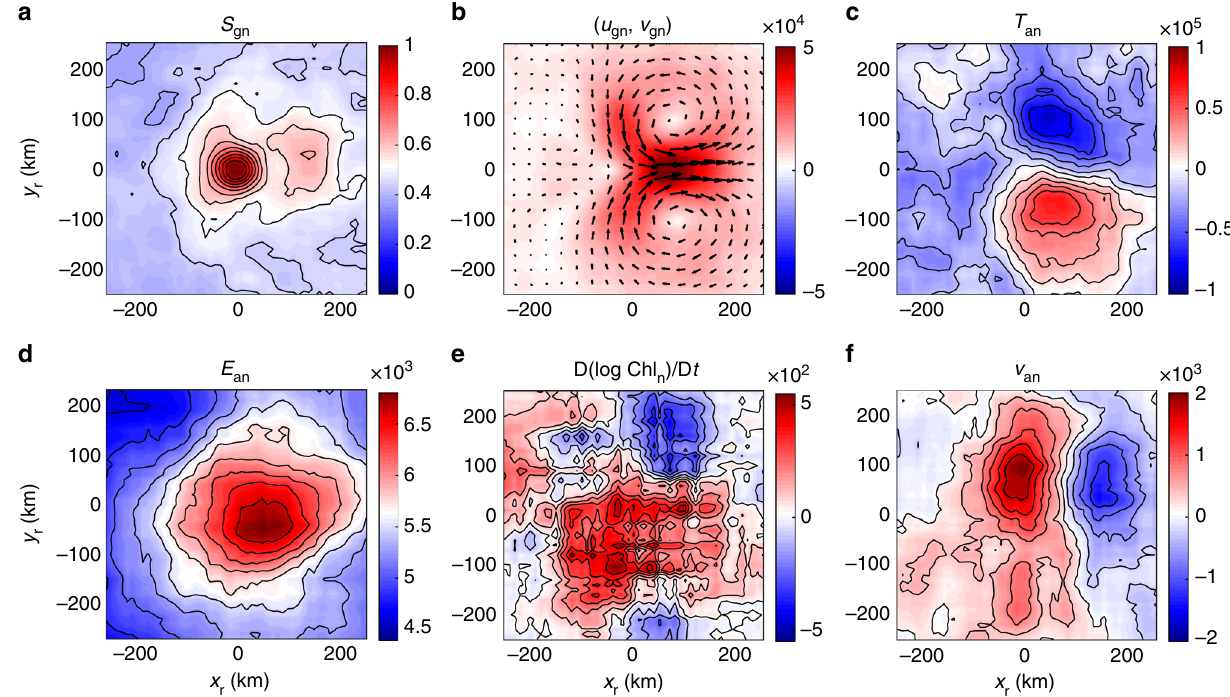
Fig. 4 Northern Hemisphere frontal processes and strong geostrophic strain. Composited distributions of normalized properties in the along-front coordinate: a normalized geostrophic strain rate S gn , b normalized geostrophic velocity fi eld ( u gn , v gn ), where the color represent the speed of the geostrophic fl ow, and the vectors represent the geostrophic velocity fi eld, c normalized surface temperature anomaly T an , d normalized ageostrophic kinetic energy E an , e normalized Lagrangian chlorophyll variation rate D(log Chl n )/D t , and f normalized cross-front ageostrophic velocity v an . All properties are normalized by the strain rate at the centered strain saddle point S gc . Thus, S gn and D(log Chl n )/D t are dimensionless, and the units of ( u gn , v gn ), T an , E an , and v an are m 1 , °C s − 1 , m 2 s − 1 , and m 1 , respectively. The along-front and cross-front directions are x r and y r , respectively. All parameters are composited using a moving window with a bin size 25 km × 25 km. Source data are provided as a Source Data fi